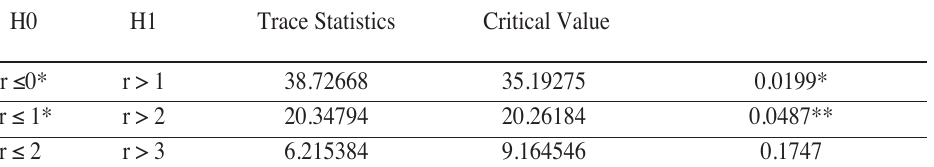
Table 4: Trace test results